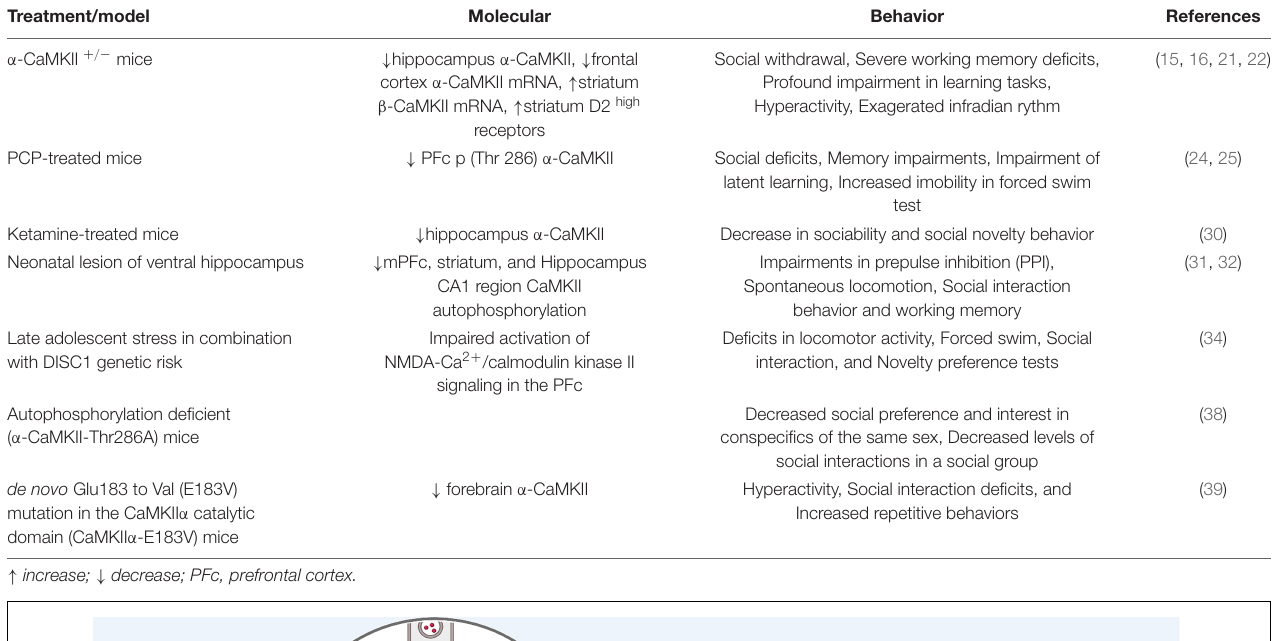
TABLE 1 | Summary of the findings reporting that dysregulated CaMKII signaling causes impaired social interaction and cognitive deficits.